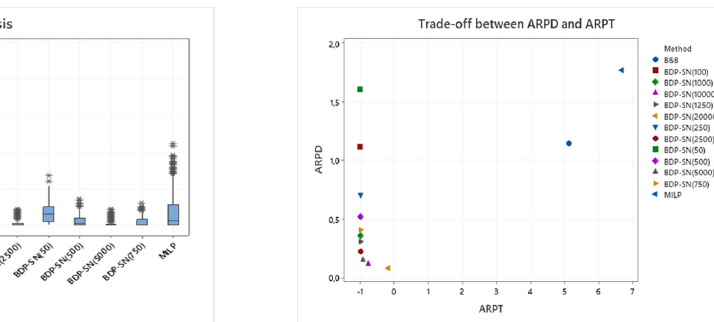
Fig. 5. Boxplot relative to the RPD data Fig. 6. Performance analysis with regard to ARPD and